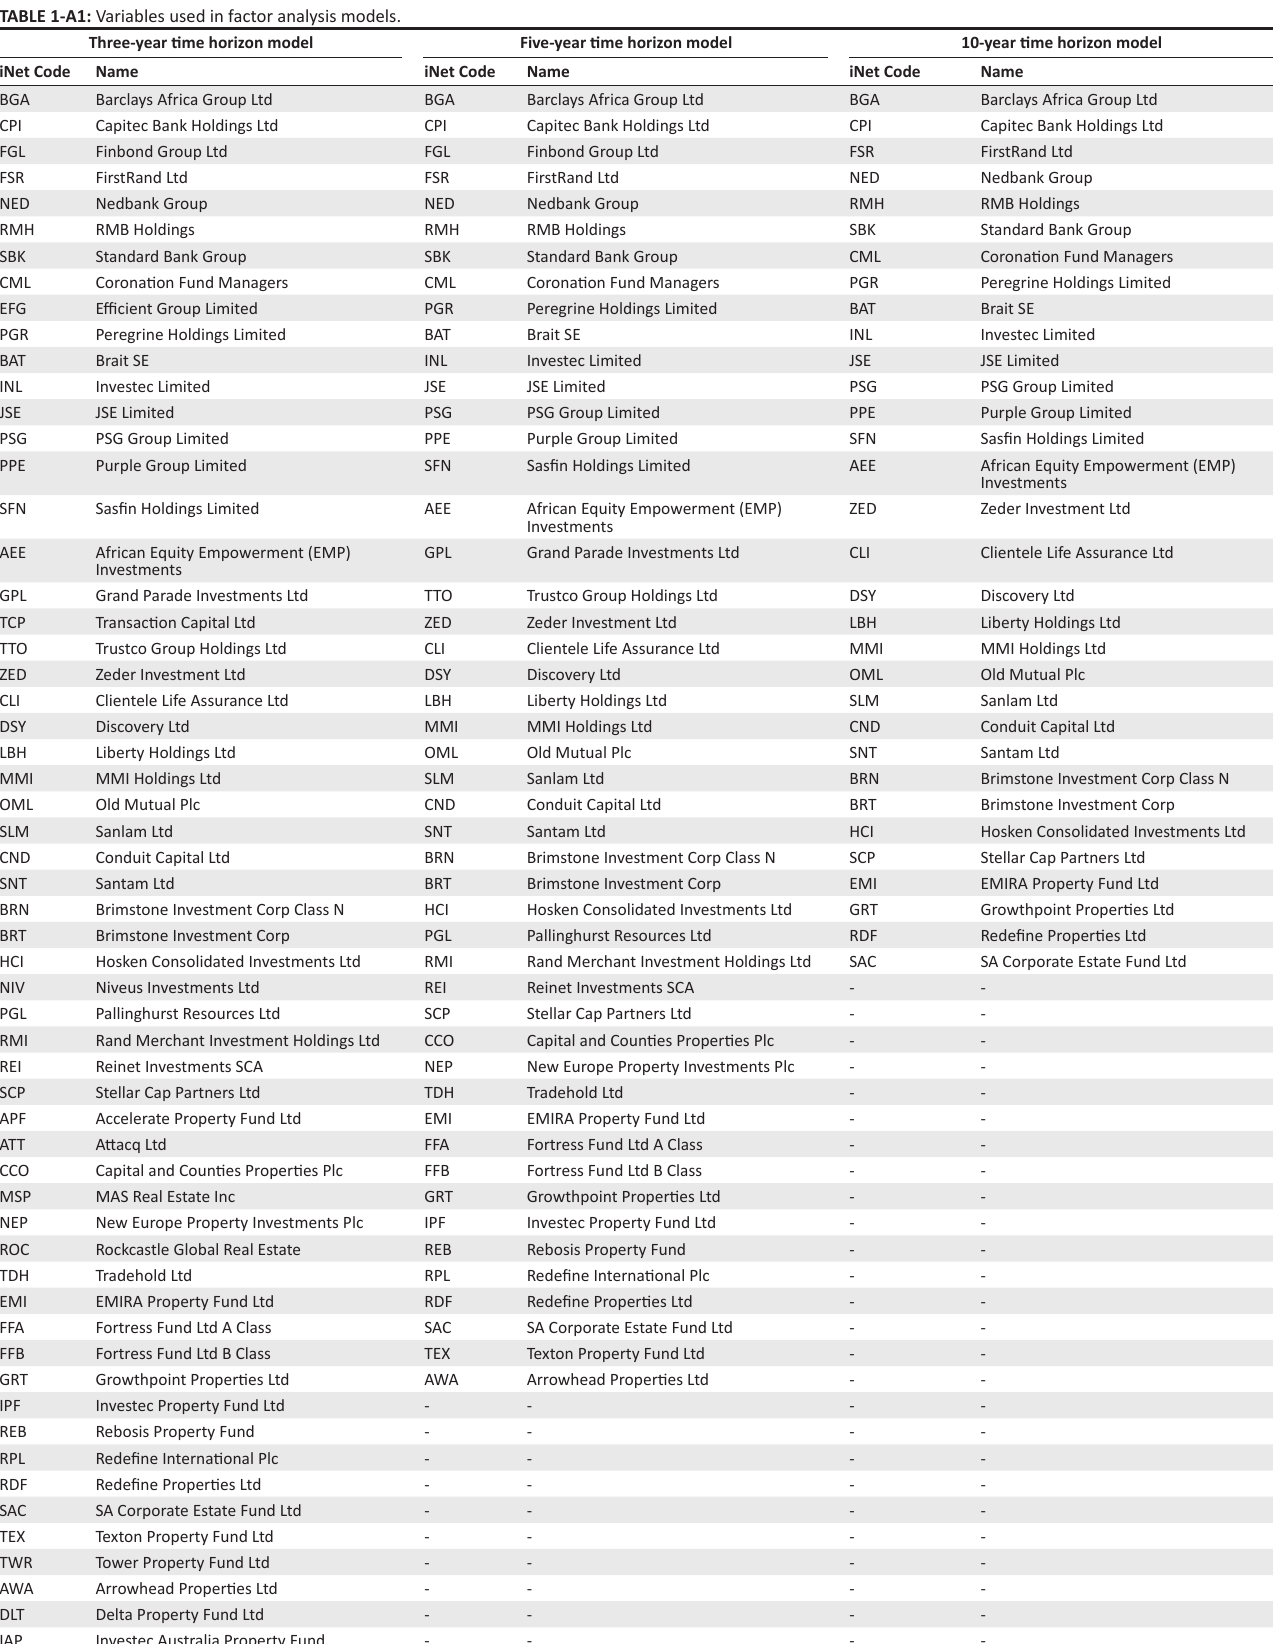
TABLE 1-A1: Variables used in factor analysis